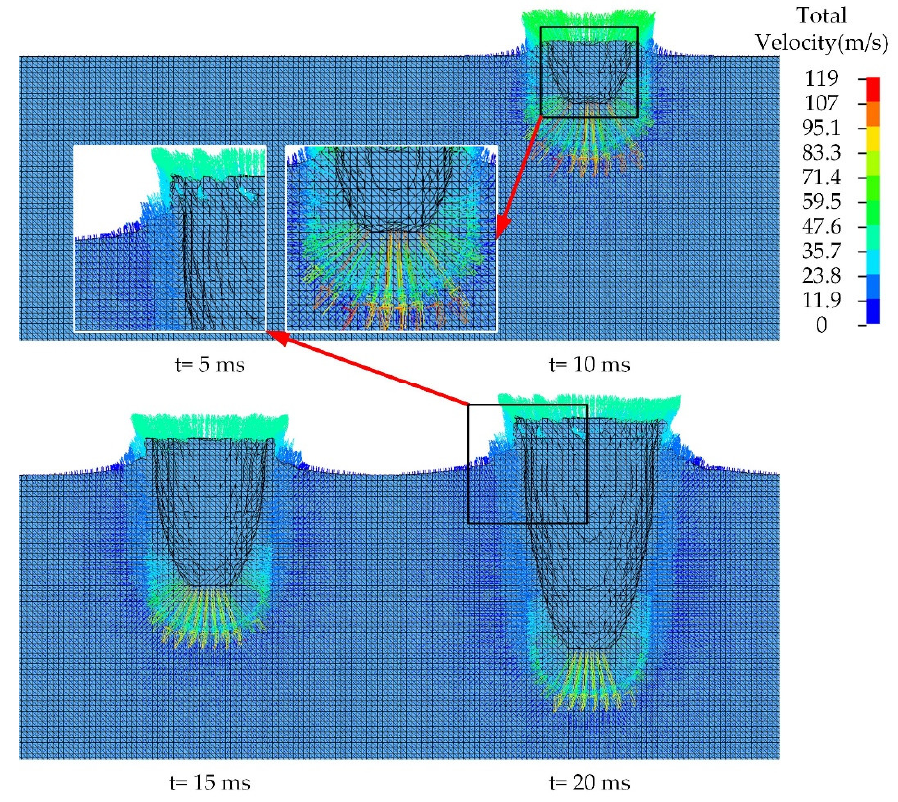
Figure 12. Schematic diagram of velocity of flow field.